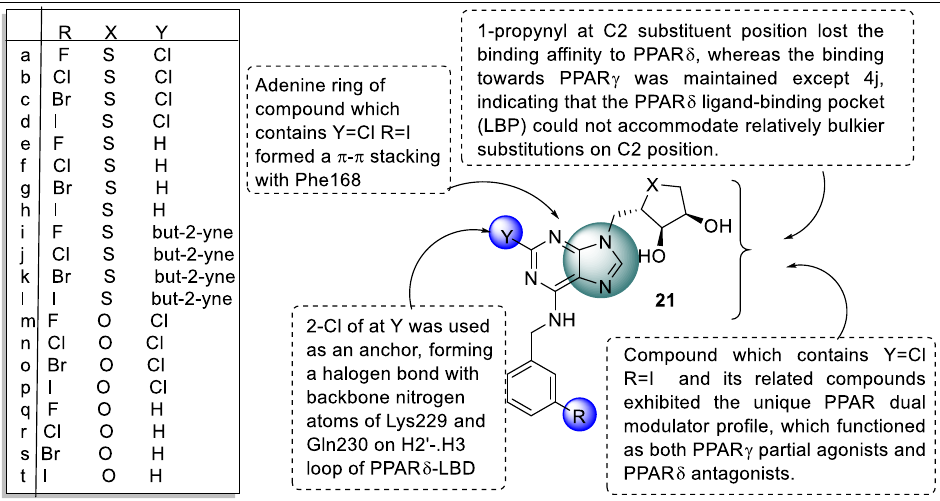
Figure 24. Structural activity relationship of Benzimidazole hybrids ( 21 ) as potent PPAR ligands.